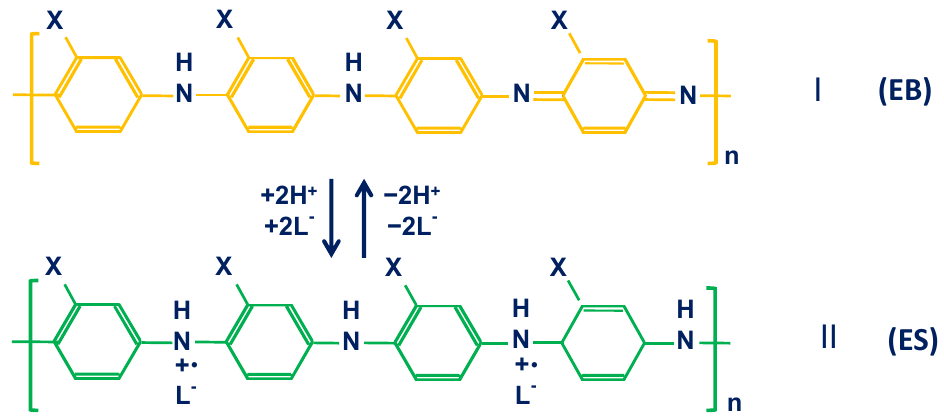
Figure 1. The mechanism of pH response for PANI and PANI derivates (X = H, CH 3 , C 2 H 5 or C 3 H 7 ) illustrating the protonation and deprotonation of the half–oxidized emeraldine–base (EB) and half-oxidized emeraldine salt (ES) forms. Reprinted with permission from [43], Copyright (2002) Elsevier.